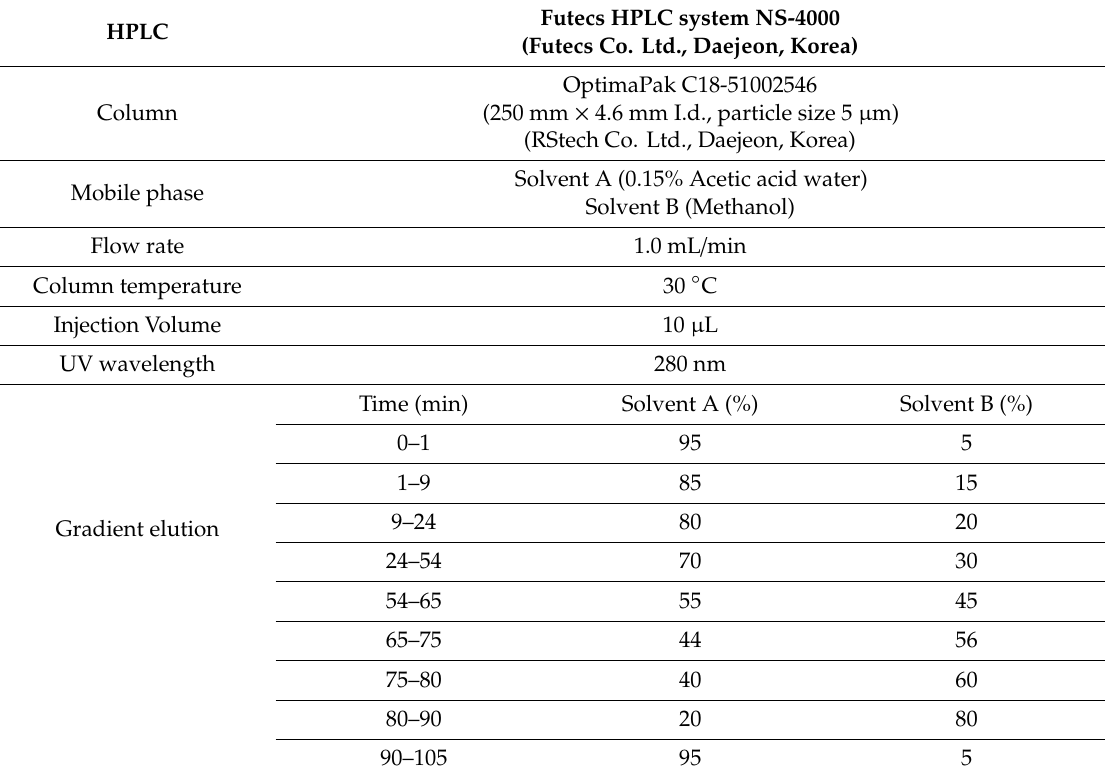
Table 1. The HPLC conditions for phenylpropanoid